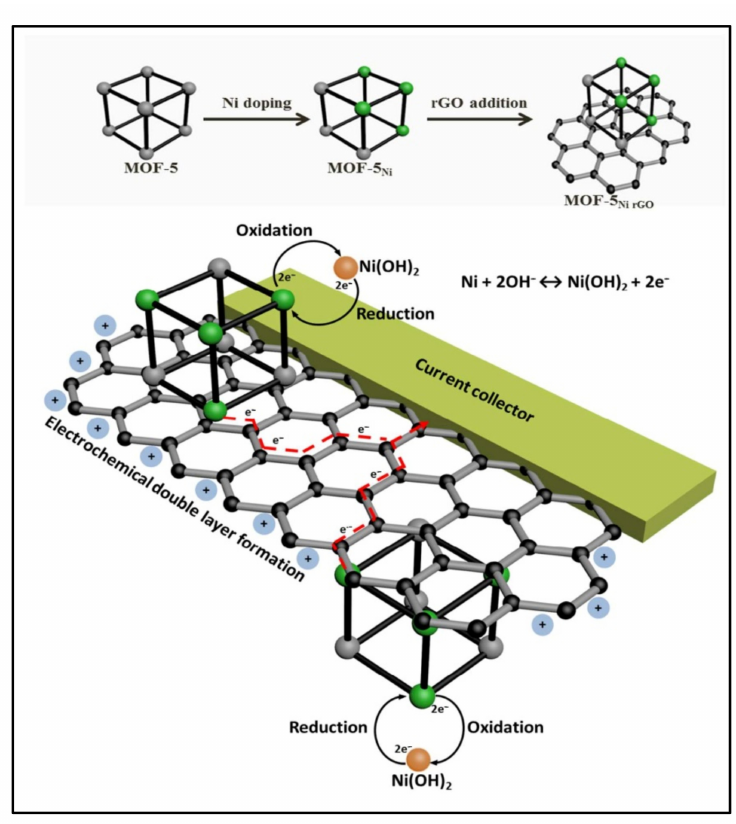
Figure 2. The concept for Ni doping and incorporation of rGO to form a composite of rGO and Ni-doped MOFs-5 and its use as an electrode material that harnesses both the electrochemical double layer performance of the rGO as well as the reversible redox reactions of the Ni metal centers with a synergy that facilitates effective and efficient charge transfer processes [26]. Reprinted (adapted) with permission from Parama Chakraborty Banerjee, Derrek E. Lobo, Rick Middag, et al. Electrochemical Capacitance of Ni-doped Metal-Organic Framework and Reduced Graphene Oxide Composites: More than the Sum of Its Parts. ACS Appl. Mater. Interfaces 2015, 7, 6, 3655–3664. Copyright (2015) American Chemical